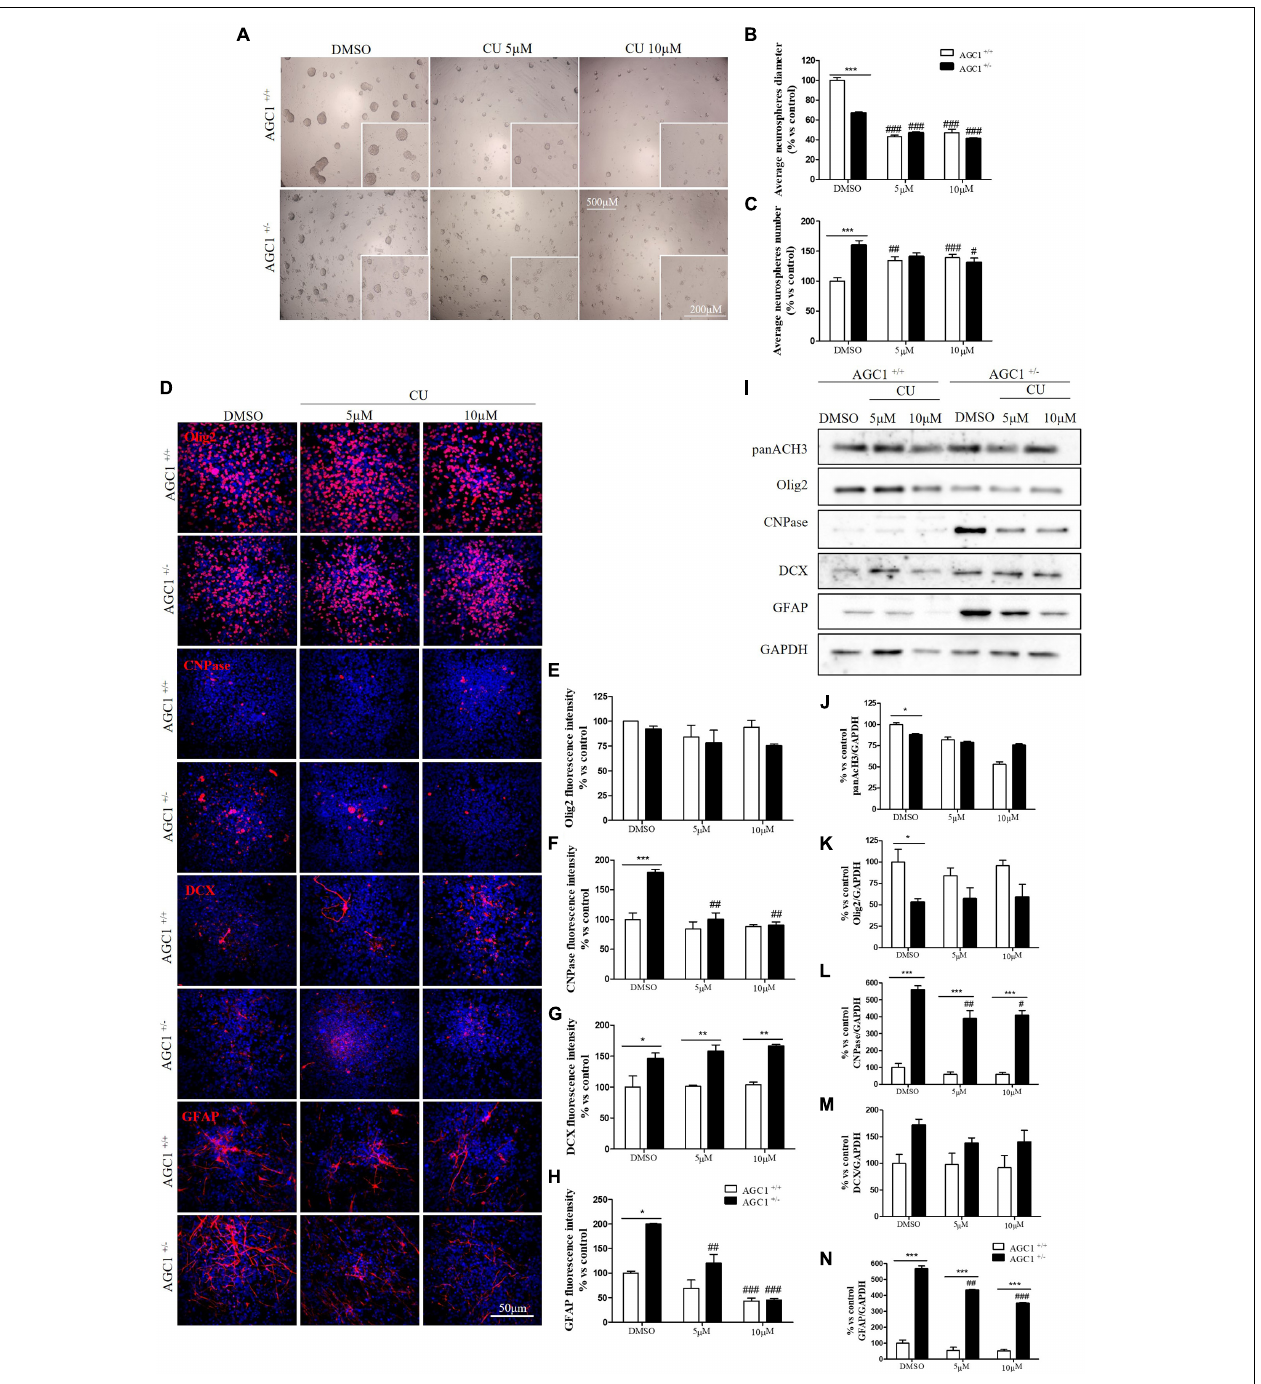
FIGURE 8 | Curcumin-mediated HAT inhibition differentially affects proliferation and glial commitment in spontaneously differentiated AGC1 + / + and AGC1 ± neurospheres. Optical microscope images (A) and counting of number (B) , and diameter (C) of neurospheres after 7 days of culture in presence of curcumin 5 and 10 µ M. Average number and size were measured with Fuji Imagej2 software using an automated colony and cell counting method; only aggregates bigger than 400 µ m 2 were considered. Values are mean ± SD of 5 different fields acquired for each condition. 10X objective; 500 and 200 µ m bar scale. Immunofluorescence staining and cell counting of Olig2 (D,E) , CNPase (D,F) , DCX (D,G) , and GFAP (D,H) on AGC1 + / + and AGC1 ± 7DIV spontaneously differentiated neurospheres following HAT inhibition with curcumin 5 and 10 µ M. Values are mean ± SD of 3 different fields acquired for each condition. 60X objective; 50 µ m bar scale. WB and relative densitometries of panAcH3 (I,J), Olig2 (I,K) , CNPase (I,L) , DCX (I,M) , and GFAP (I,N) expression in AGC1 + / + and AGC1 ± differentiated neurospheres following HAT inhibition with curcumin 5 and 10 µ M. Values are mean ± SD of 3 independent experiments. # p < 0.05, ## p < 0.01, ### p < 0.001, compared to DMSO control, respectively; * p < 0.05, ** p < 0.01, *** p < 0.001, compared to each treated control; two-way ANOVA (Bonferroni’s post hoc test).